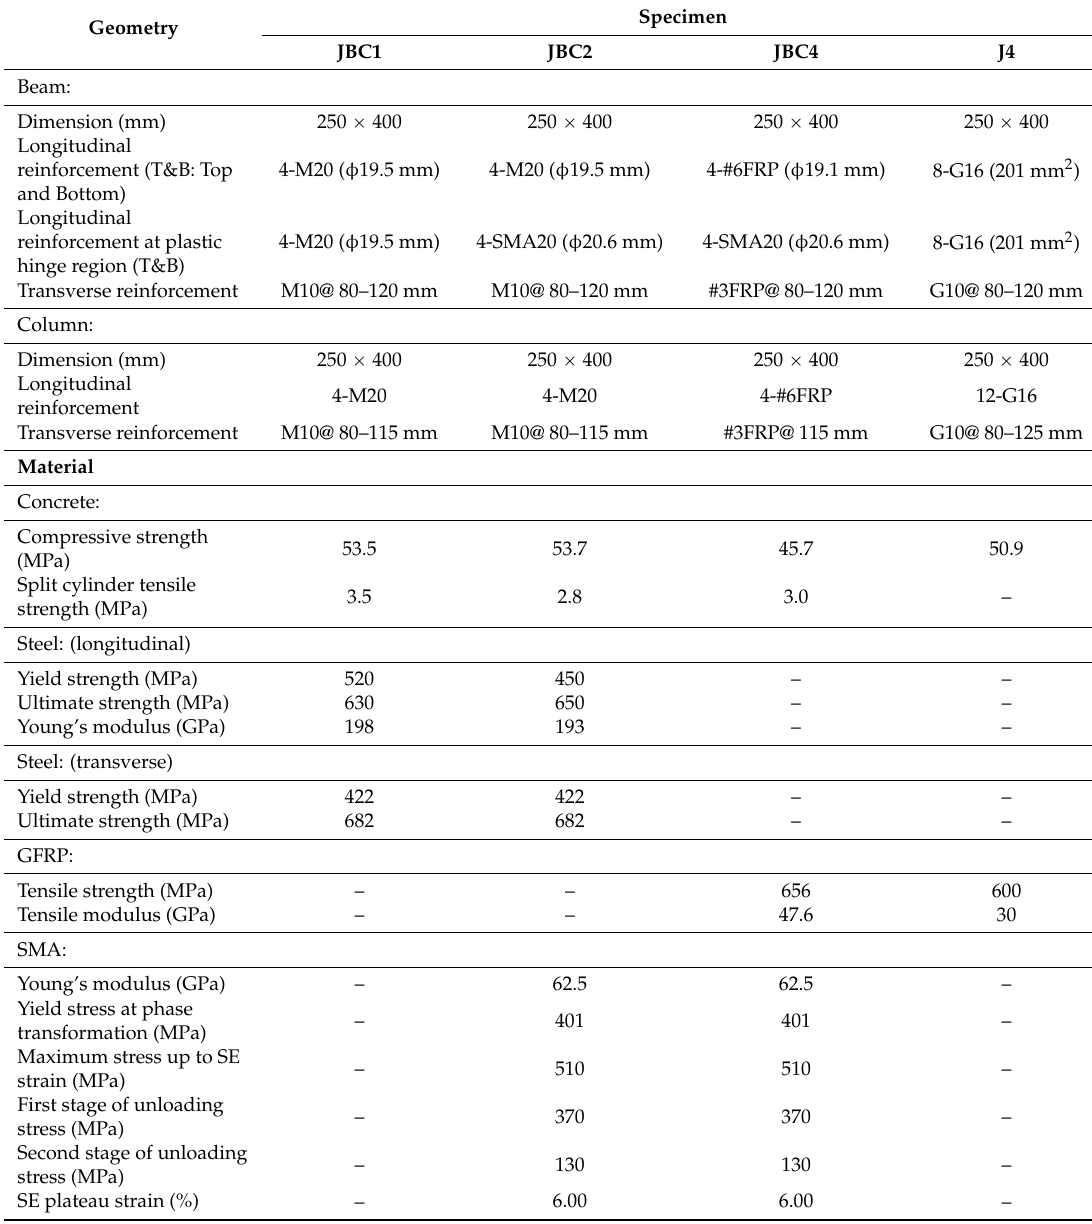
Table 1. Material properties and geometric details of